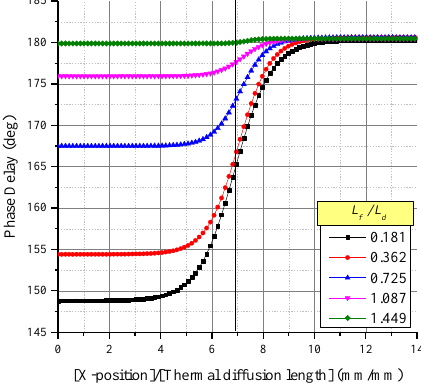
Figure 9. Boundary response functional performance with changes in 𝐿 𝑓 /𝐿 𝑑 .